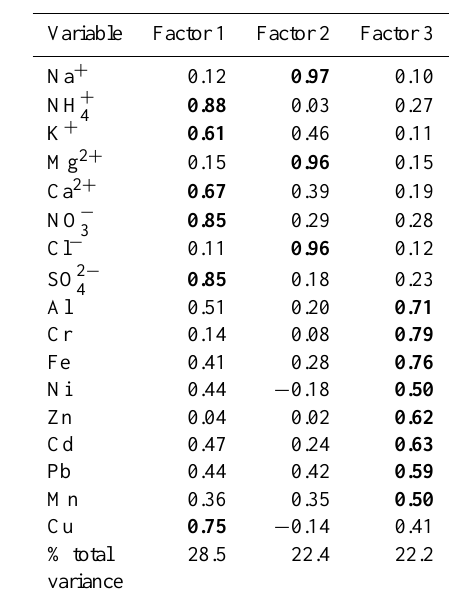
Table 8. Factor analysis of chemical constituents in rainwater. Bold numbers are significant at > 0 .